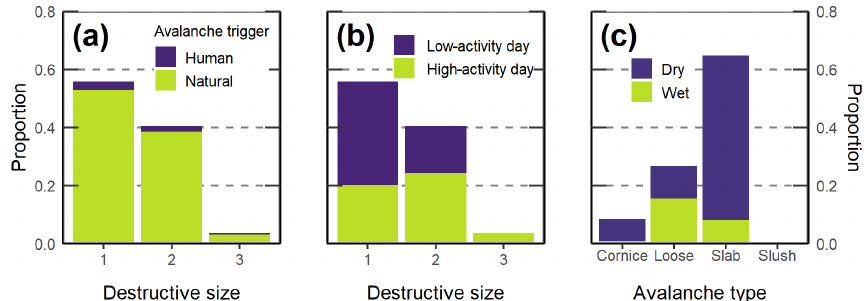
Figure 4. Summary of individual avalanches in the regObs data. Panel (a) shows the proportion of observed avalanches triggered naturally and artificially by destructive size, panel (b) shows the proportion of observed avalanches falling into low- and high-activity days by destructive size class, and panel (c) shows the proportion of observed avalanche wetness by avalanche type.